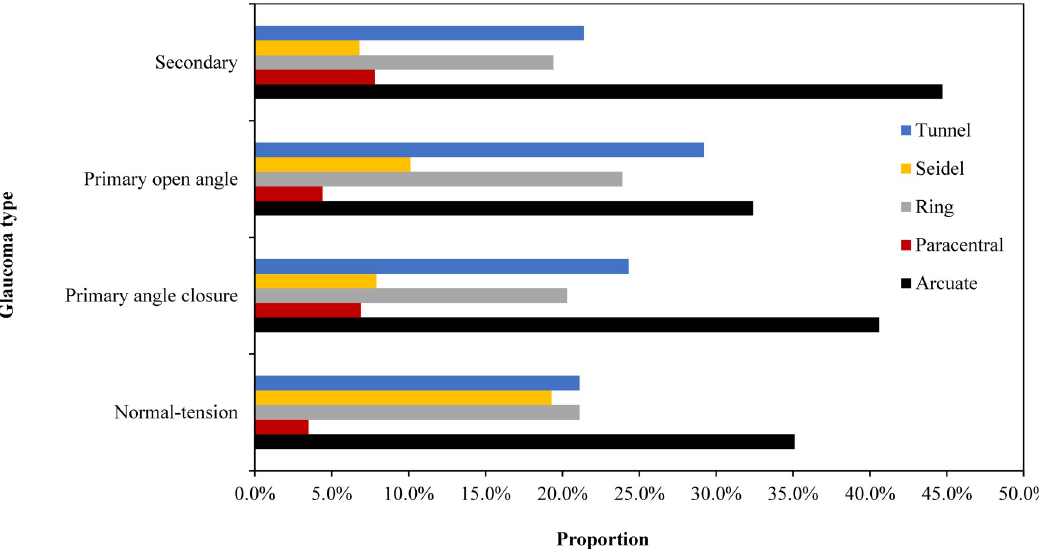
Fig 3. Percentage distribution of the visual field defect by glaucoma